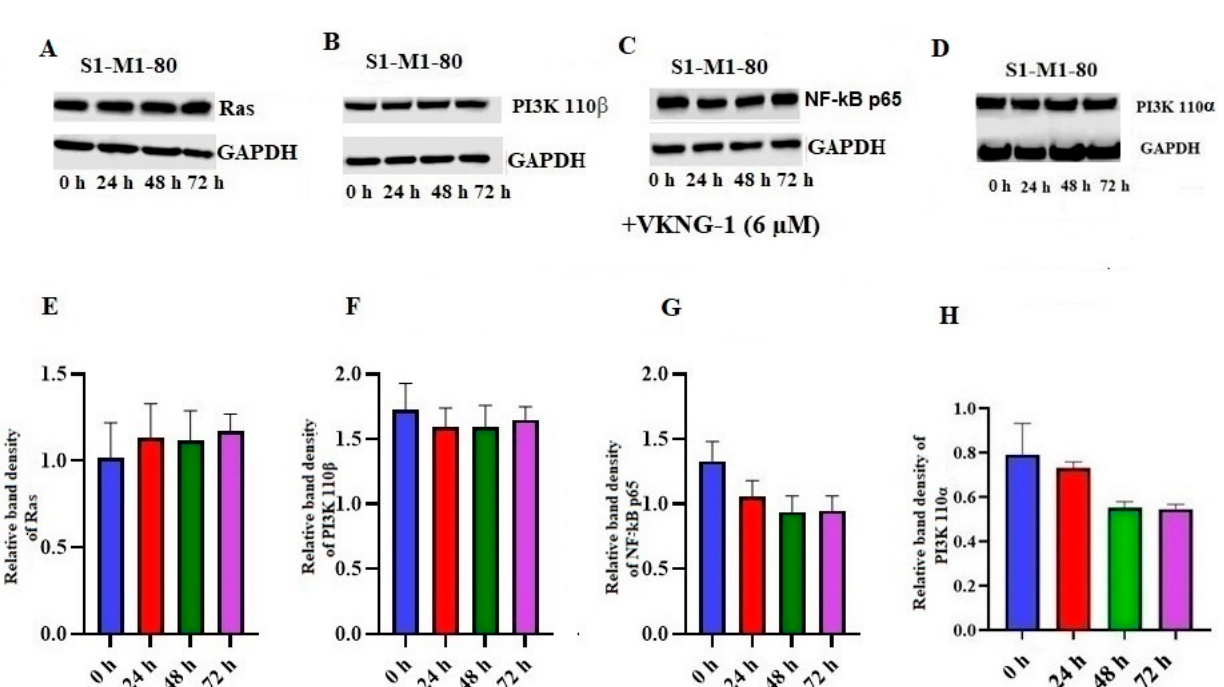
Figure 7. Effect of VKNG-1 on the expression of Ras, PI3K 110 α , β and NF-kB p65: The relative intensity of Ras ( A ), PI3K 110 β ( B ), NF-kB p65 ( C ) and PI3K 110 α ( D ) was tested after the cells were treated with 6 µ M of VKNG-1 for 24, 48 and 72 h. Relative quantification of the effect of VKNG-1 on Ras ( E ), PI3k 110 β ( F ) and NF-kB p65 ( G ) and PI3K 110 α ( H ) in S1-M1-80 cells. The expression levels of the target proteins, Ras, PI3K 110 α and β and NF-kB p65 were normalized to GAPDH. Equal amounts of total cell lysates were employed for each sample and Western blot analysis was conducted.